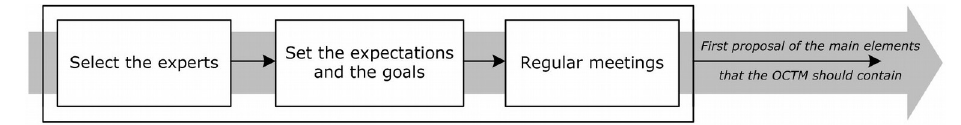
Figure 5. Workflow of Work Element Definition